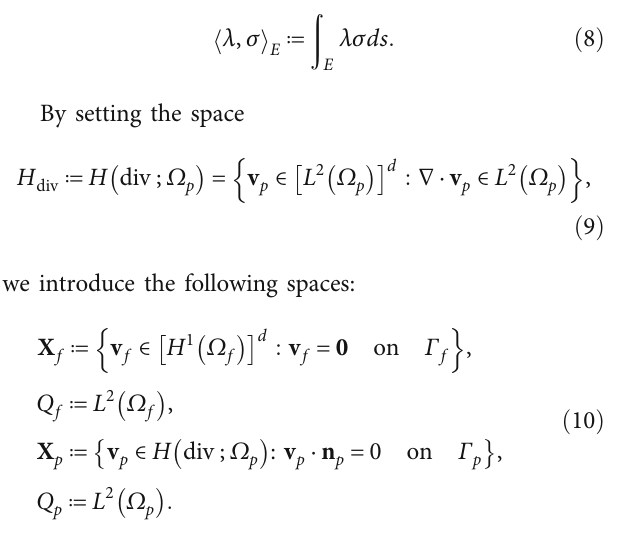
separated by the interface Γ p